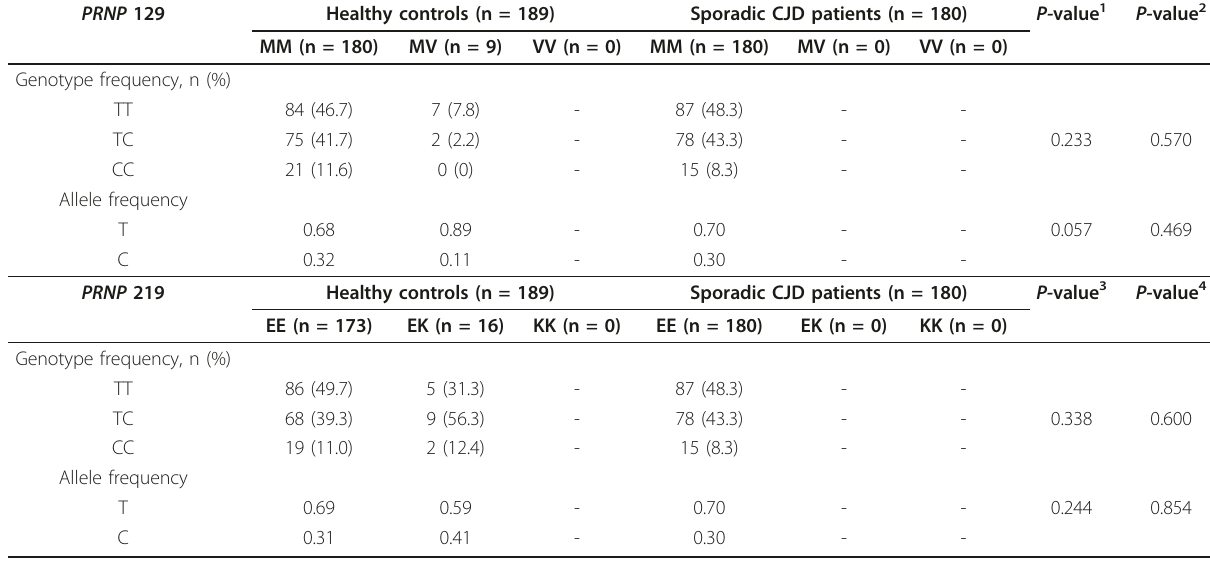
Table 6 Genotype and allele frequencies of RPSA 5-UTR -8T>C polymorphism according to the PRNP codon 129 or 219